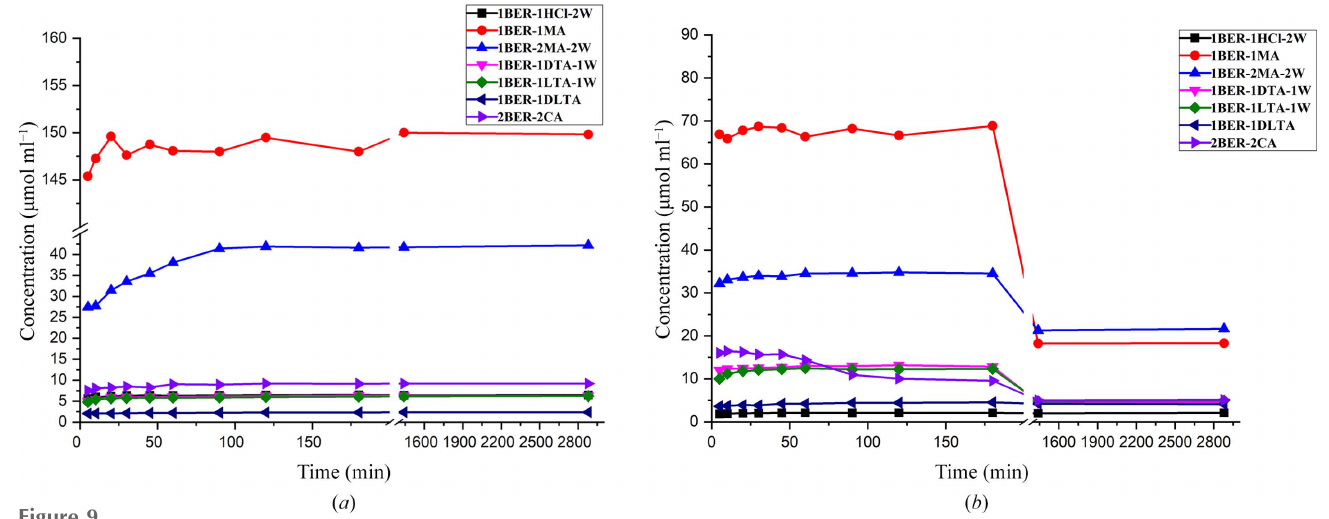
Figure 9 Dissolution profiles of the solid forms obtained in ( a ) pure water and ( b ) dilute hydrochloric acid